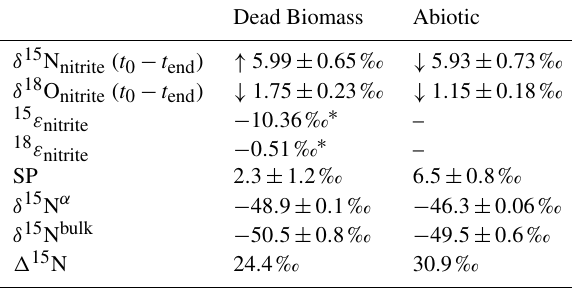
Table 3. Comparison of the isotope values obtained during the dead biomass vs. the abiotic experiments. t 0 values represent means cal- culated by summarizing the results across all pH levels ± standard − x t error. δ 15 N and δ 18 O values were calculated using x t ; an 0 end overall increase from the initial value is marked with “ ↑ ”, and a decrease from the initial value is marked with “ ↓ ”. The calculated isotope fractionation factor ( ε ) is based on the slope between the lowest initial value (here at t 1 ) and t end for all pH levels. (cid:49) 15 N ( = δ 15 N nitrite − δ 15 N 2 O bulk ) was calculated for the end of the ex- periment. Dead Biomass